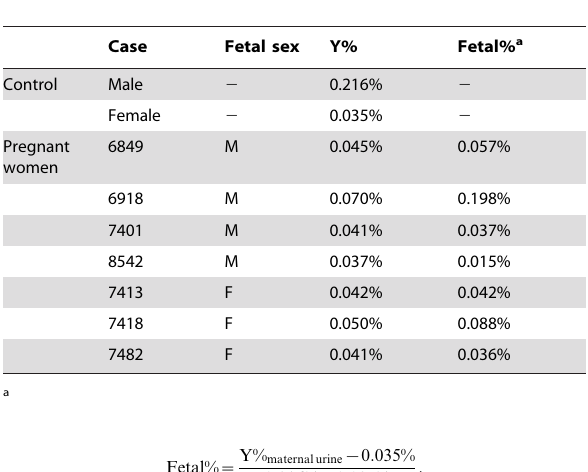
Table 1. Fractional fetal DNA concentrations in maternal urine as calculated by the chromosome Y approach.